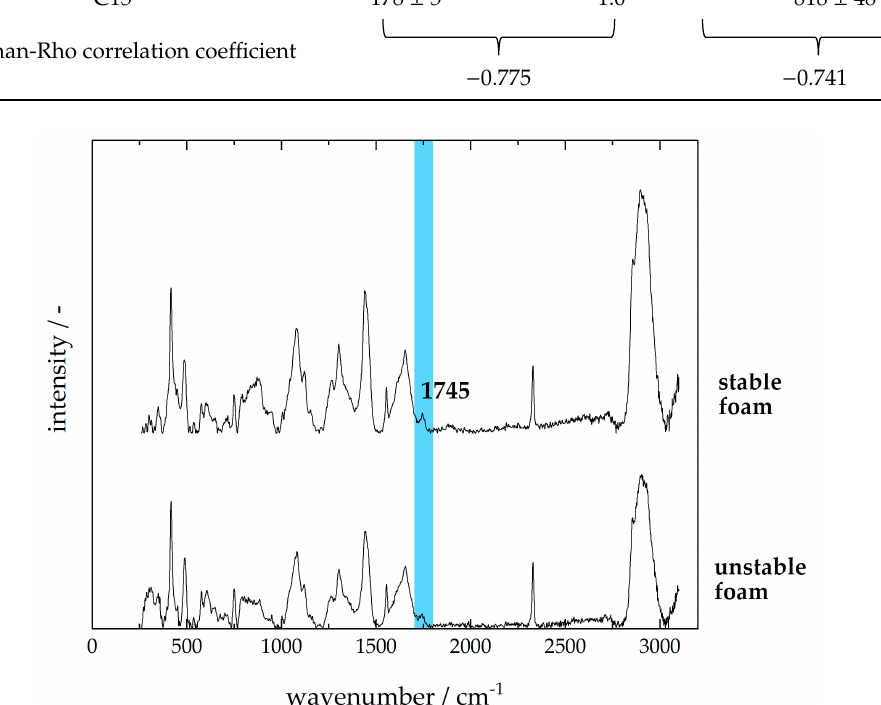
Figure 7. Raman spectra of milk forming stable (C4) and unstable (C15) foams are given Spectra are offset for clarity. Highlighted in blue is the peak corresponding to the ν (C=O) stretching vibration in an ester.